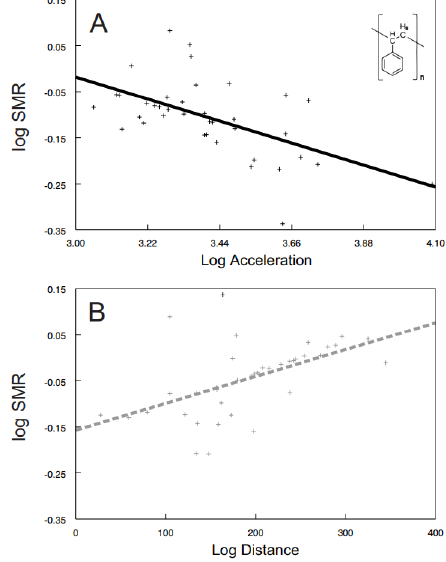
Figure 5. The relationship between distance and acceleration of control shrimps. Predicted values